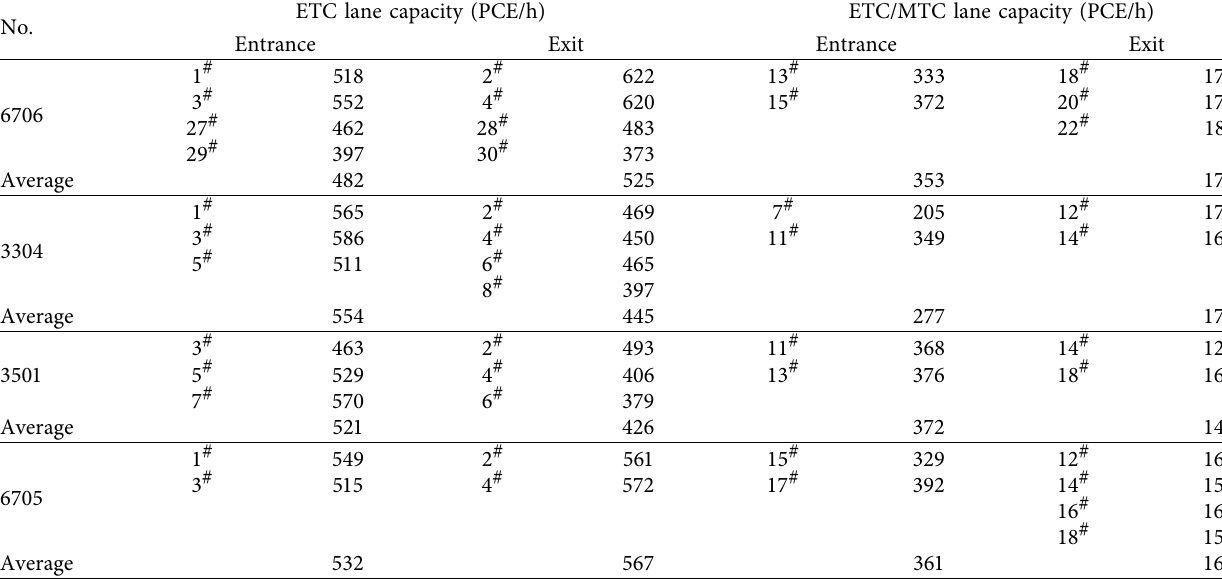
Table 7: Capacity of diferent lanes at toll